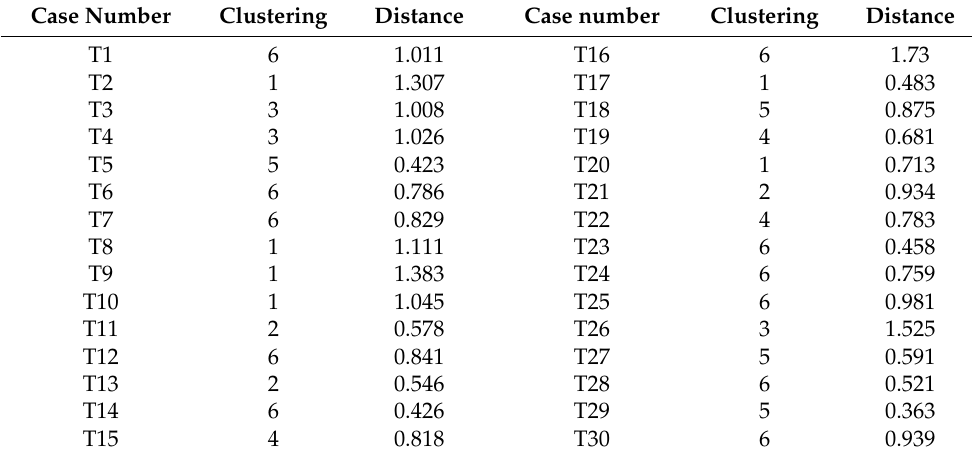
Table 1. Cluster members and distance values.